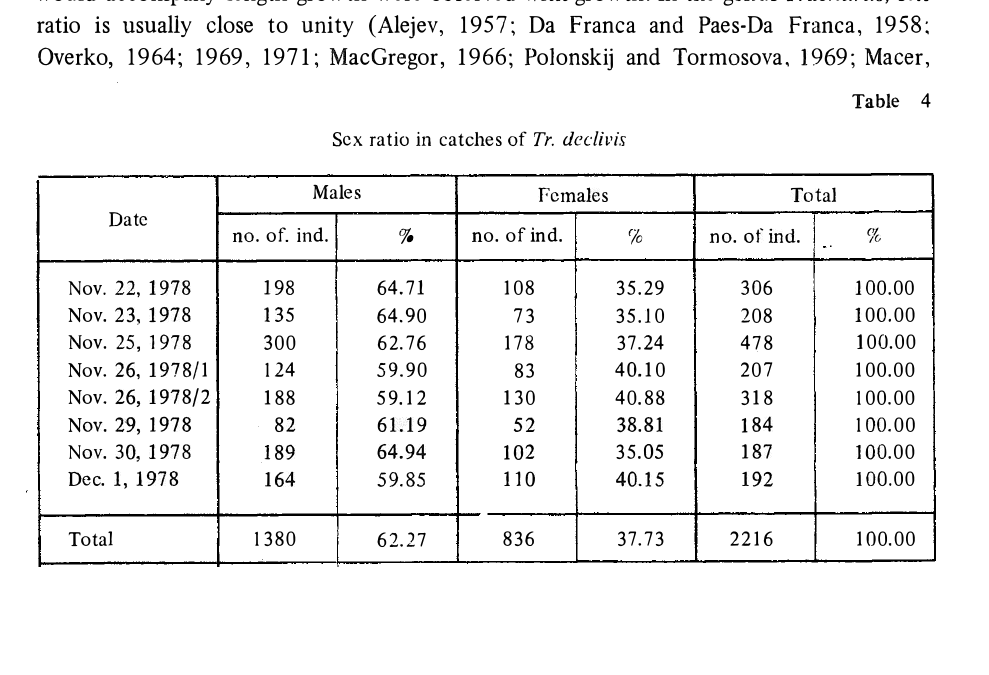
Sex ratio in catches of Tr. declivis Males